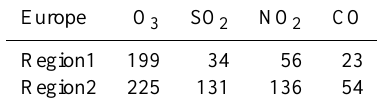
Table 1. Number of rural receptors by species and regions. Europe O 3 SO